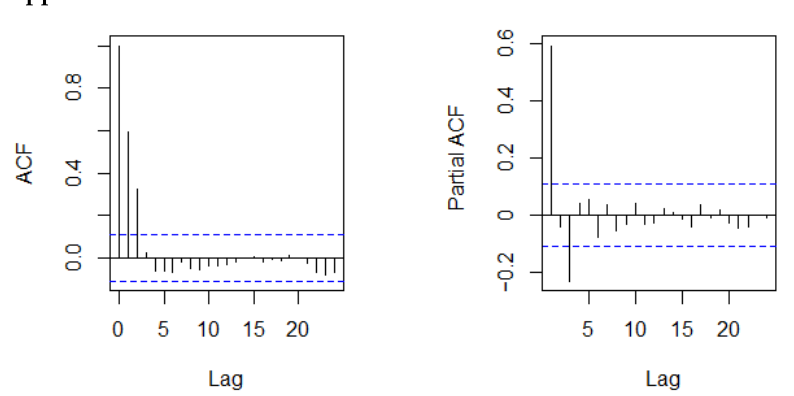
Figure A1. Autocorrelation function (ACF) and partial autocorrelation function (PACF) for milk price.